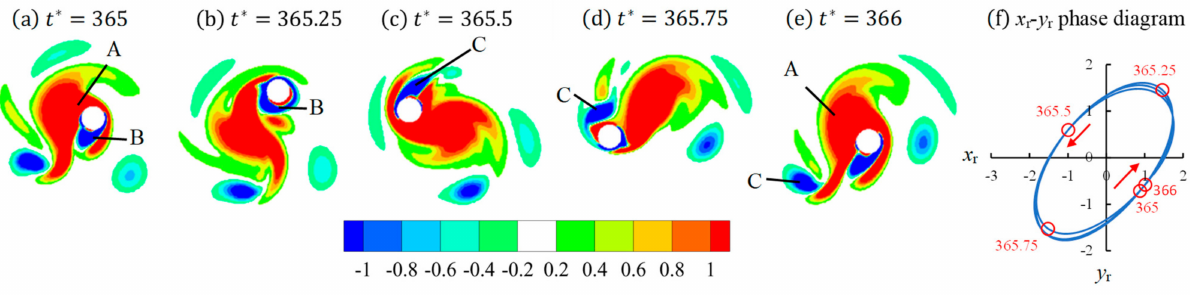
Figure 9. Regime R for β = 45 ◦ , KC = 10, f ∗ = 0.9 within one period starting from t ∗ =